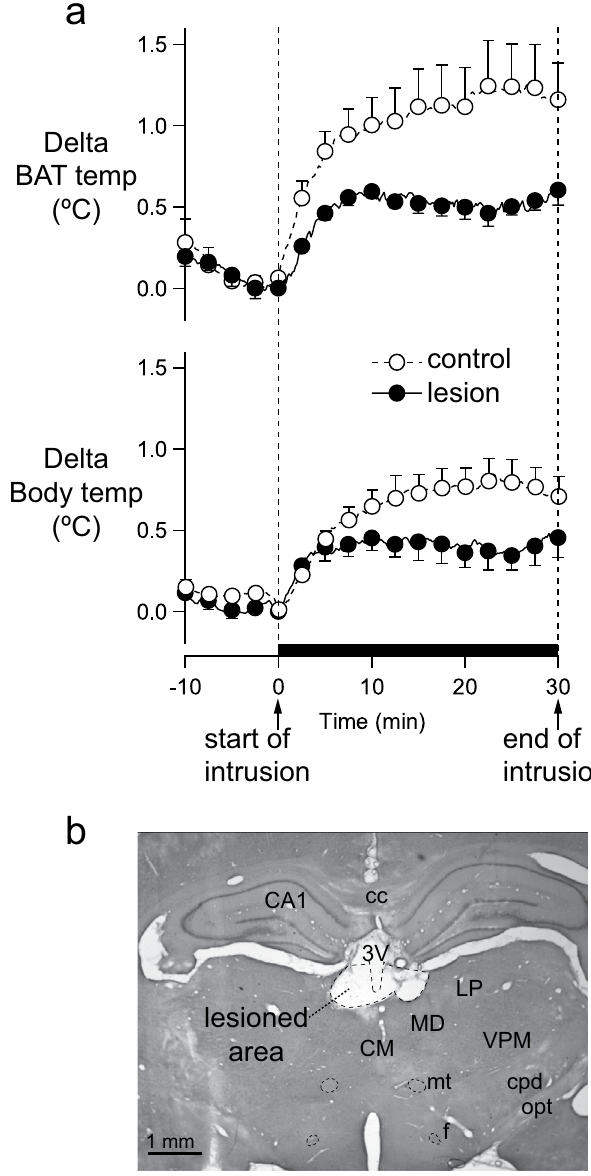
Figure 1. Effect of electrical lesion of the LHb on BAT thermogenesis elicited by the introduction of an intruder in the resident rat cage. ( a ) Averages (mean ± SEM) of original records of BAT and body temperature in the resident rat during the 10 min pre-intruder period and 30 min intruder exposure period. For lesioned rats, data are shown as solid line with filled circled. For control rats, data are shown as dashed lines with open circles. The intrusion period is indicated by the thick horizontal bar. ( b ) Histological demonstration of electrically lesioned area in the LHb. CA1, field CA of hippocampus; cc, corpus callosum; CM, central medial thalamic nucleus; cpd, cerebral peduncle; f, fornix; LP, lateral posterior thalamic nucleus; MD, mediodorsal thalamic nucleus; mt, mammilothalamic tract; opt, optic